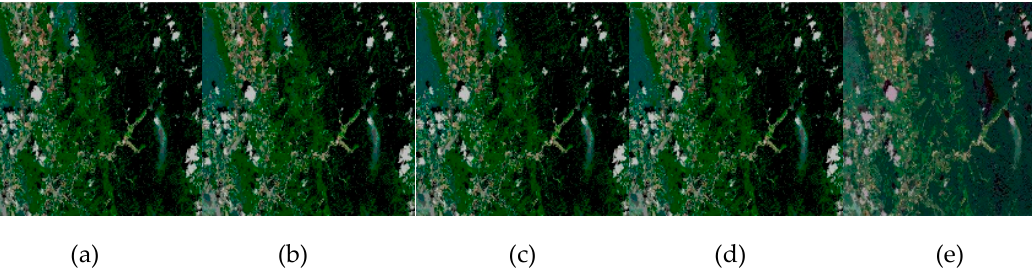
Figure 13. The segmented results of Satellite image6. ( a ) WOA; ( b ) FPA; ( c ) PSO; ( d ) BA; and ( e ) HSOA.